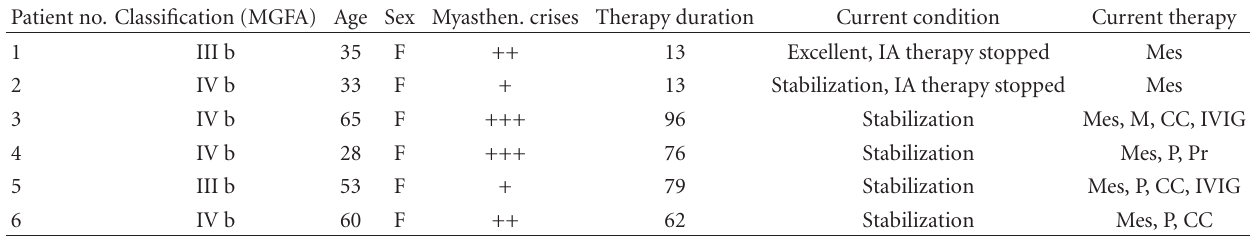
Table 1: Basic clinical data. Number of myasthenic crises experienced requiring artificial ventilation: + = 1-2, ++ = 2–5, +++ = more than 5. IA = immunotherapy, Mes: Mestinon, M: Medrol, P: Prednison, CC: CellCept, Pr: Prograf.